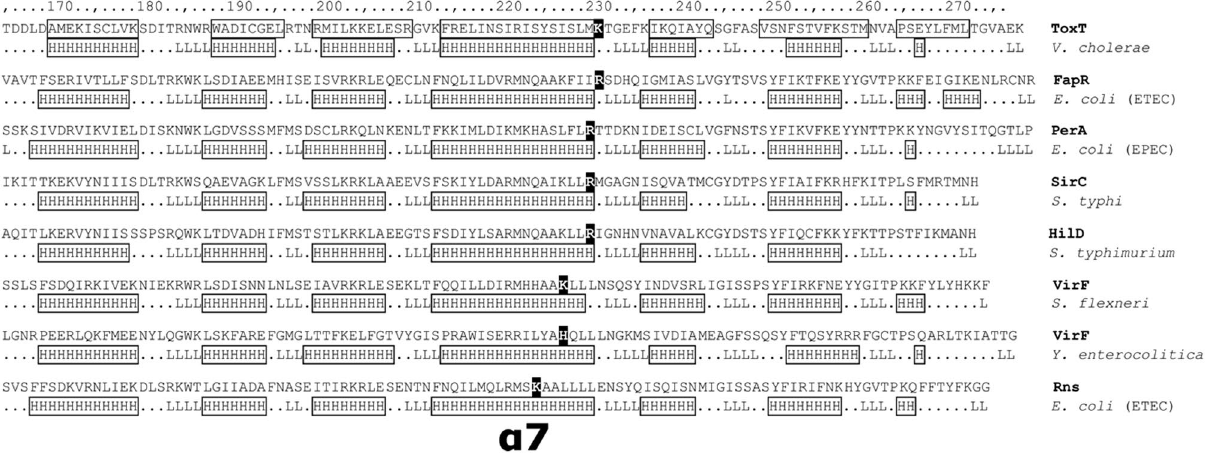
Figure 1. Structural alignment of the C-terminal domains of the top AraC family hits. ToxT is shown at the top with structurally determined α-helices shown in boxes. For the other proteins, H indicates predicted α-helices and L indicates predicted loop regions. The position of α7 is indicated and the positive residues are highlighted for each sequence. Predictions by the PROF algorithm using the server at http:// predi ctpro tein.